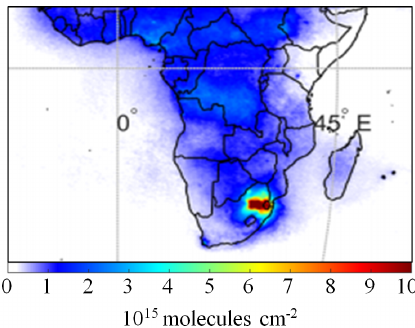
Figure 1. Global map of long-term average tropospheric NO 2 column derived from SCIAMACHY data from August 2002 to March 2012 (Schneider et al.,